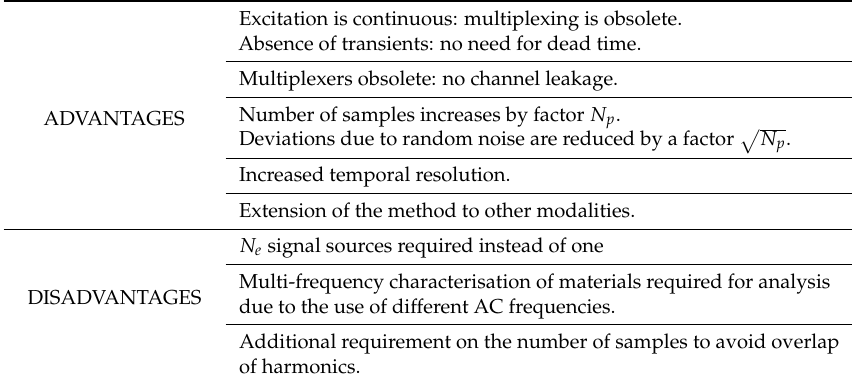
Table 3. Features of the ONE-SHOT